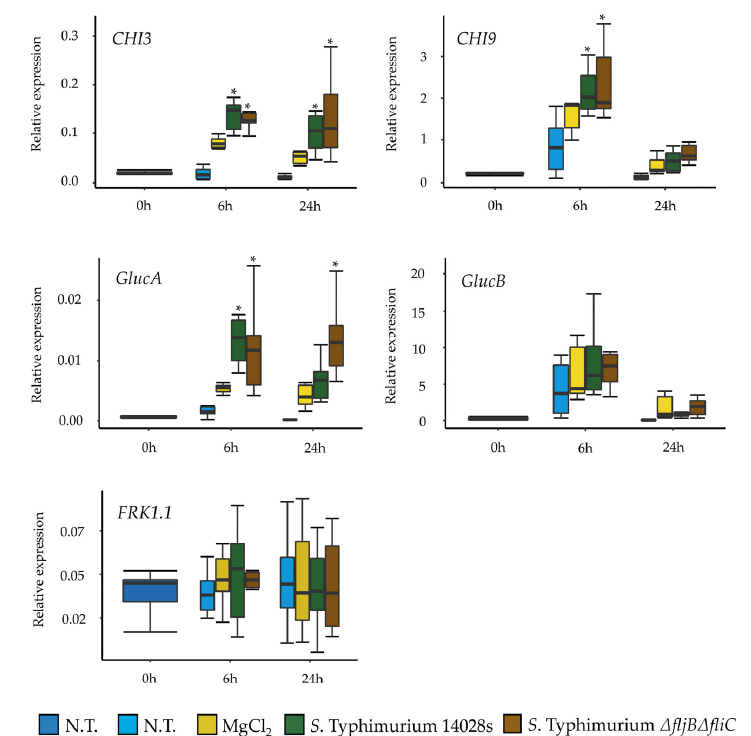
Figure 7. Flagella is not the only PAMP recognized by tomato. Response to inoculation with S. Typhimurium 14028s and the double mutant S. Typhimurium ∆ fljB ∆ fliC was monitored in tomato plants by assessing the transcriptional activation of several Pathogenesis - Related genes. The expression of CHI3 , CHI9 , GlucA , GlucB and FRK1.1 was normalized using the expression of tomato Actin . The amount of mRNA was assessed in non-treated plants (N.T.) and 6 as well as 24 h (hpi) after challenge with 10 mM MgCl 2 , S. Typhimurium 14028s or the S. Typhimurium ∆ fljB ∆ fliC mutant. The experiment was conducted in six replicates, in each on which three plants per treatment were pooled and used for RNA extraction. Asterisks indicate p ≤ 0.05 in Tukey HSD test. For more information about significant di ff erences among treatments, please see Supplementary Table